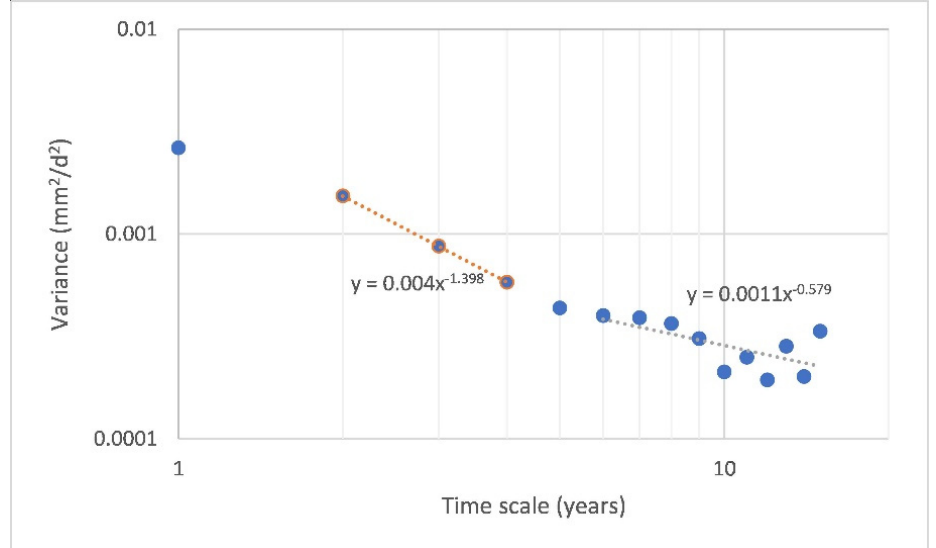
Figure 5. Climacogram separating short and long time scales for average precipitation over Australia (GPCC Version 2022 data set). The fitted linear relationship for the short time scales gives H = 0.30, reflecting the influence of ENSO, which is anti-persistent, while for the longer time scales, H = 0.71, reflecting LTP.